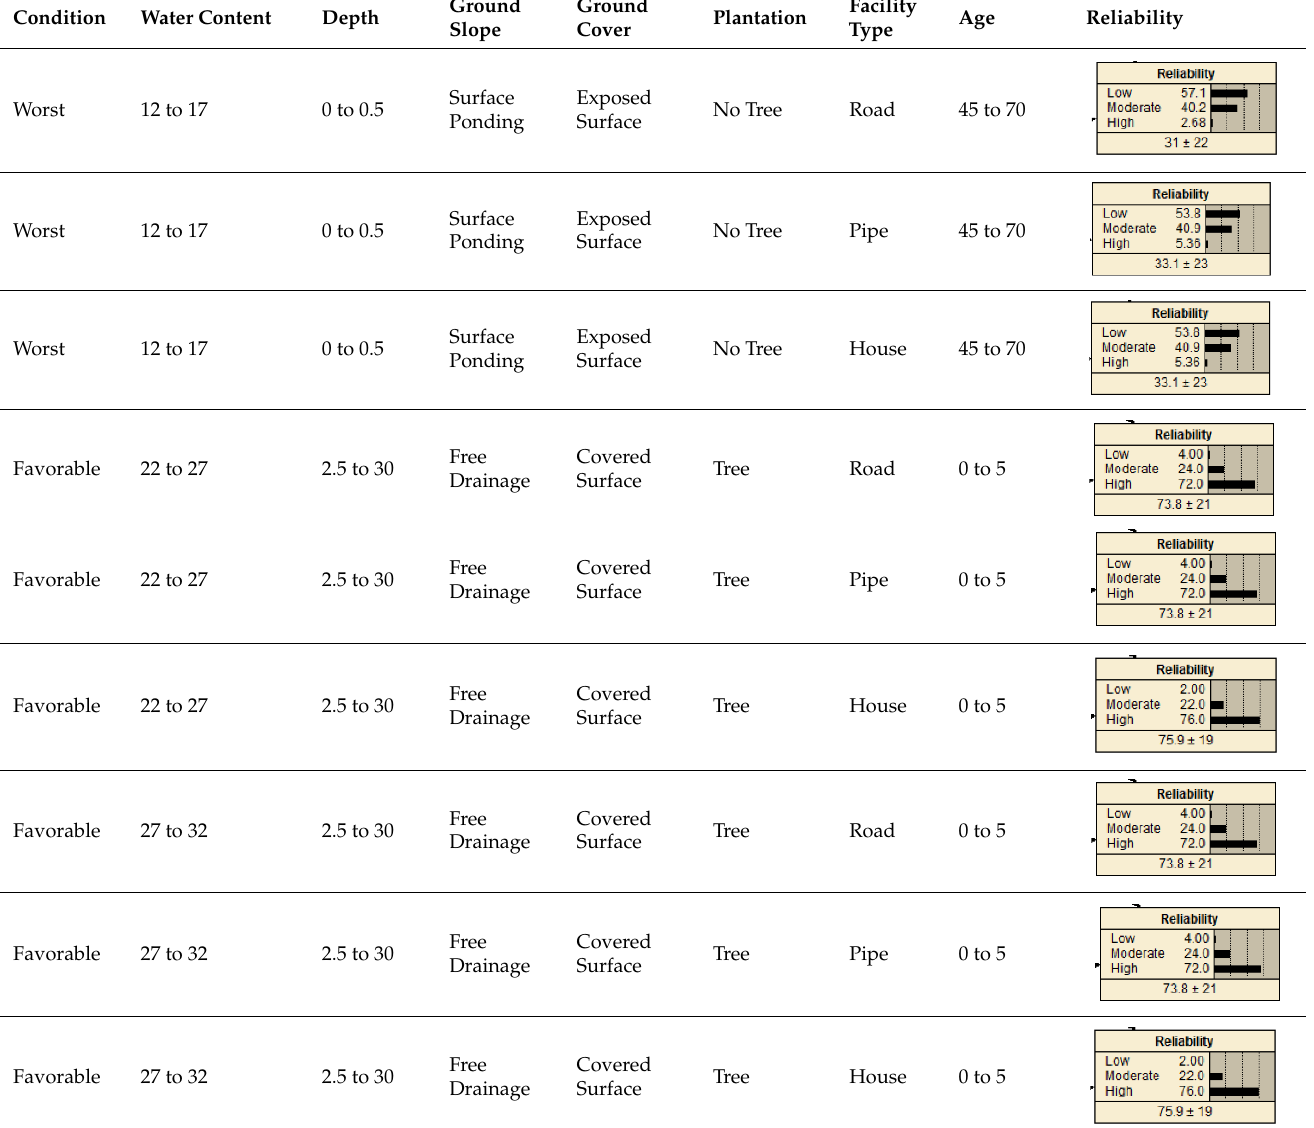
Table 4. Summary of extreme scenario analysis.